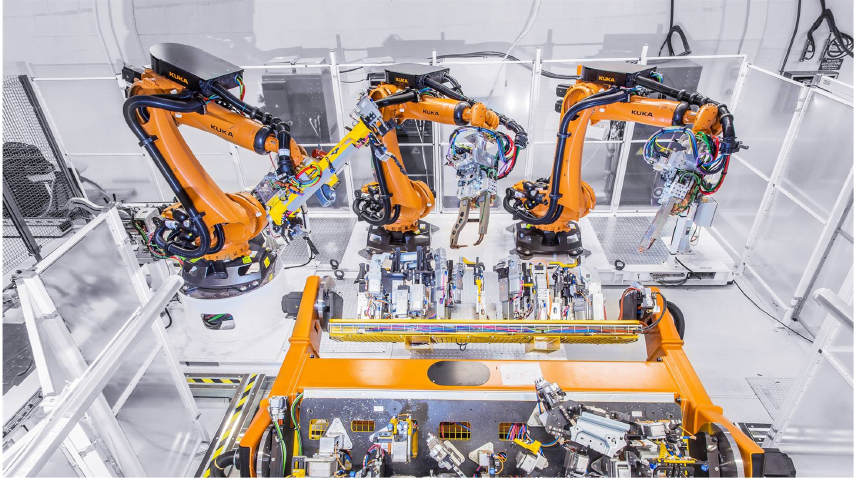
Figure 1. General view of KUKA robots in the spot welding process